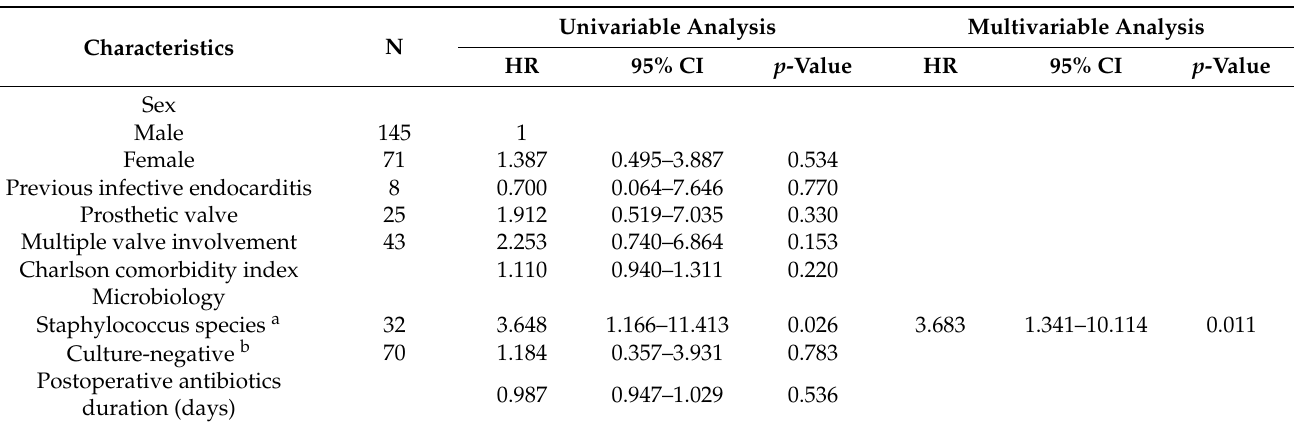
Table 3. Univariable and multivariable logistic regression analysis of the 1-year composite outcome in patients with infective endocarditis.